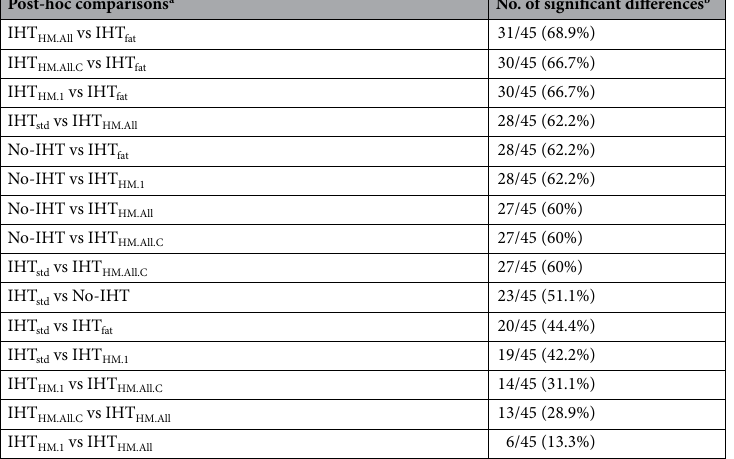
Table 2. Summary of the per-radiomics features (RFs) analysis. a Post-Hoc comparisons correspond to the post-hoc Bonferroni-corrected Tukey tests for repeated-measures ANOVAs where the influence of the intensity harmonization techniques (IHT) on the 45 RFs was investigated. b The number (no.) of significant differences corresponds to the number of RFs that were significantly different in a given post-hoc comparisons between 2 IHTs or the raw radiomics dataset, without IHT—named No-IHT (with percentage over the total number of RFs in parentheses). HM histogram matching, No.